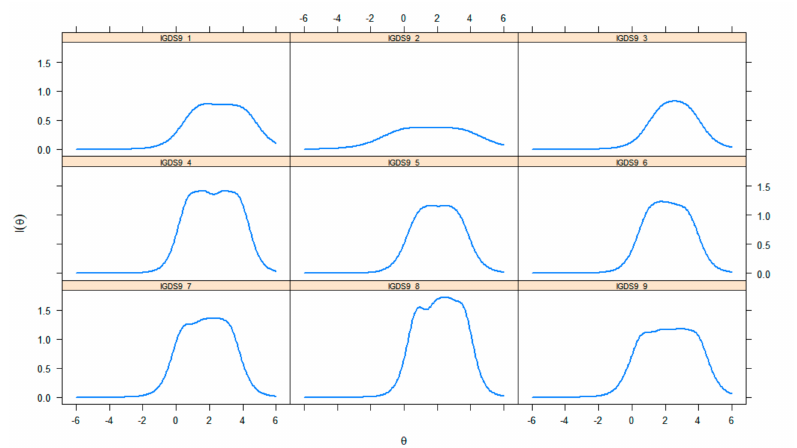
Figure 3. Internet Gaming Disorder Scale-Short Form (IGDS9-SF) item information curves.